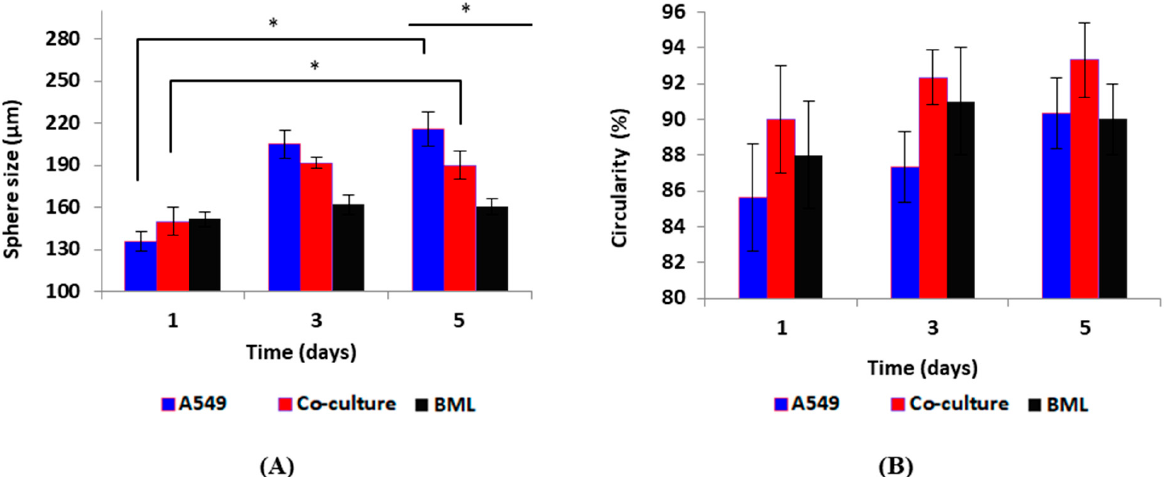
Figure 2. Spheroids size and circularity during the five days of culture. ( A ) Spheroid size changes in three groups during the five days of culture. Spheroid size increased significantly on day 5 compared to day 1 for mono-culture and co-culture spheroids (D1 vs. D7 * p < 0.05). The increase in the size of BML spheroids was not statistically significant when comparing day 5 to day 1. On day 5, the size of the three groups of spheroids was significantly different when compared to each other (* p < 0.05). ( B ) Change in circularity in the spheroids during the five days of culture. This shows how the spheroids’ shape is spherical and uniform. Spheroids in all three groups had a homogenous circularity and spherical form. Circularity did not change statistically significant when comparing day 5 to day 1 for the three groups. Circularity was not significantly different on day 5 when comparing the three groups. The total initial number of cells was 1 × 10 6 cells/mL in all three groups. p < 0.05 was considered statistically significant. All assays were performed as triplicates per trial in three independent experiments. (Error bars represent ± SE, n = 3).